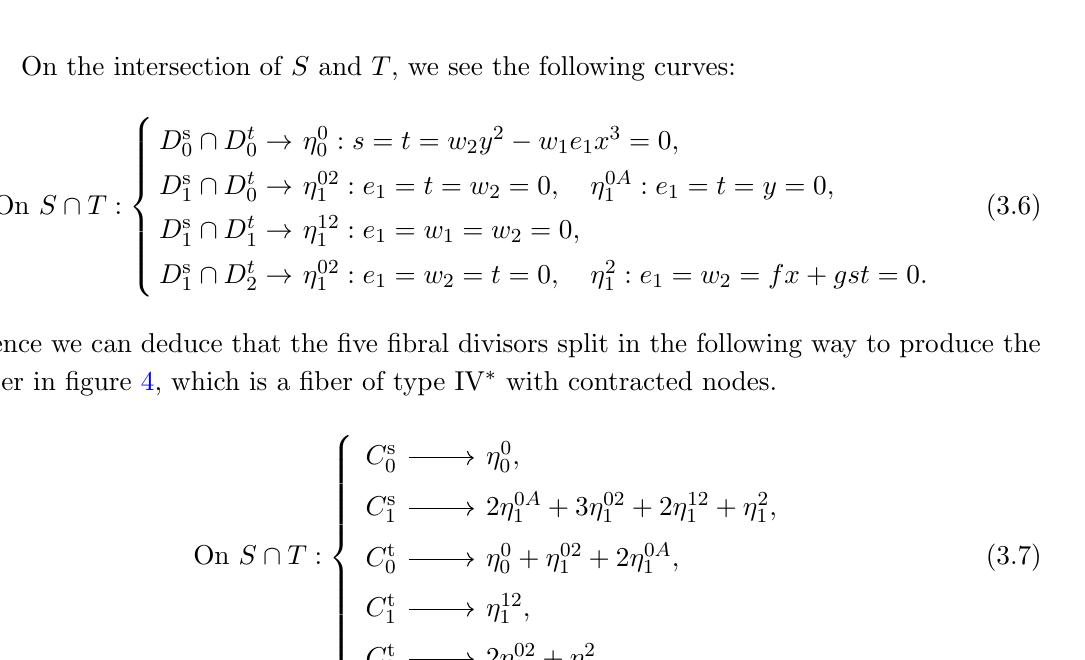
Table 5 . Weights and representations of the components of the generic curve over S \ T in Resolution I of the SU(2) (cid:2) G 2 -model. See section 4.2 for more information on the interpretation of these